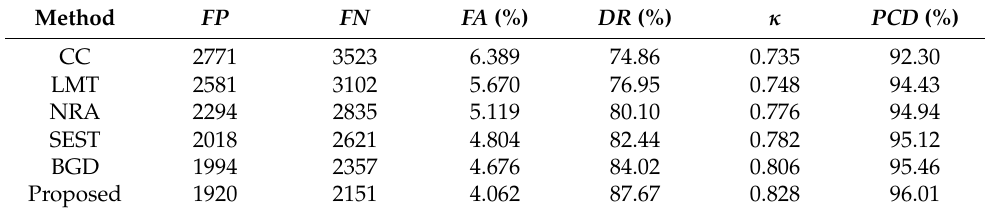
Table 5. Comparison of results from all the six methods using dataset 2 after median